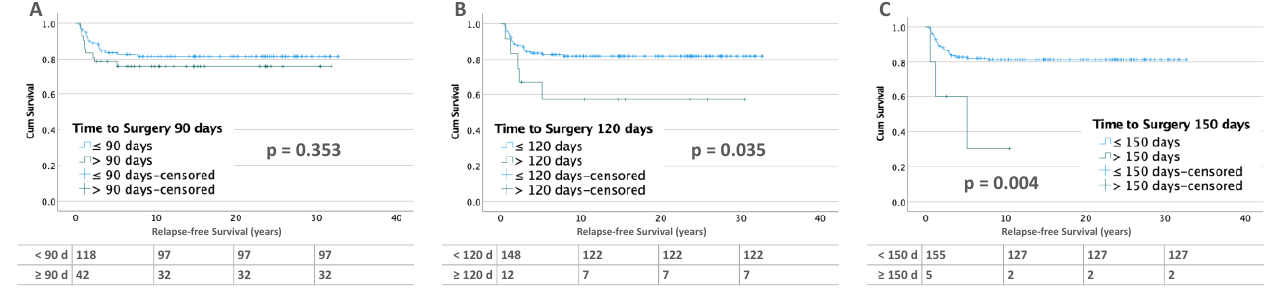
Figure 4. Kaplan–Meier lifetables of RFS of bilateral WT without metastases at diagnosis at thresholds of 90 ( A ), 120 ( B ), and 150 ( C ) days of preoperative chemotherapy. In the tables below the figures, the numbers at risk are reported.